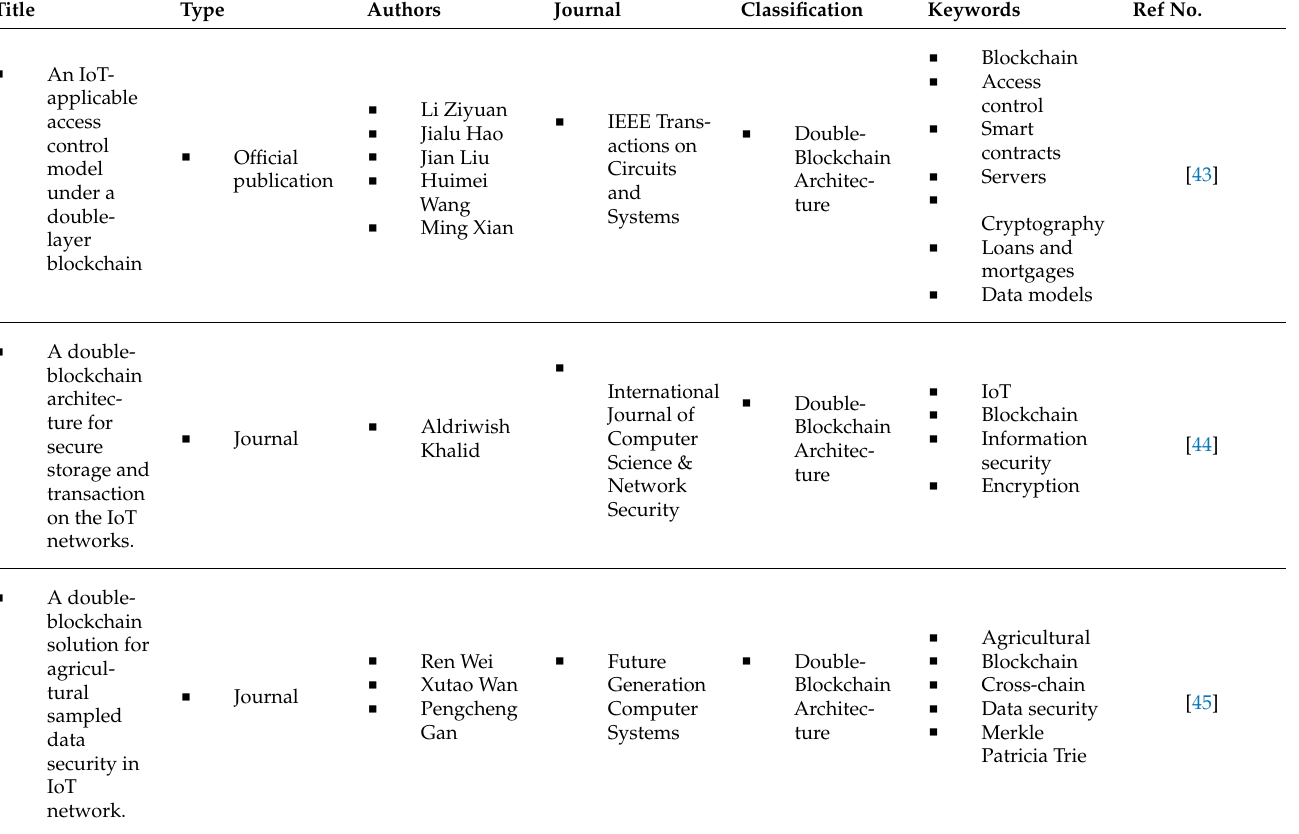
Table 3. Selected Articles.